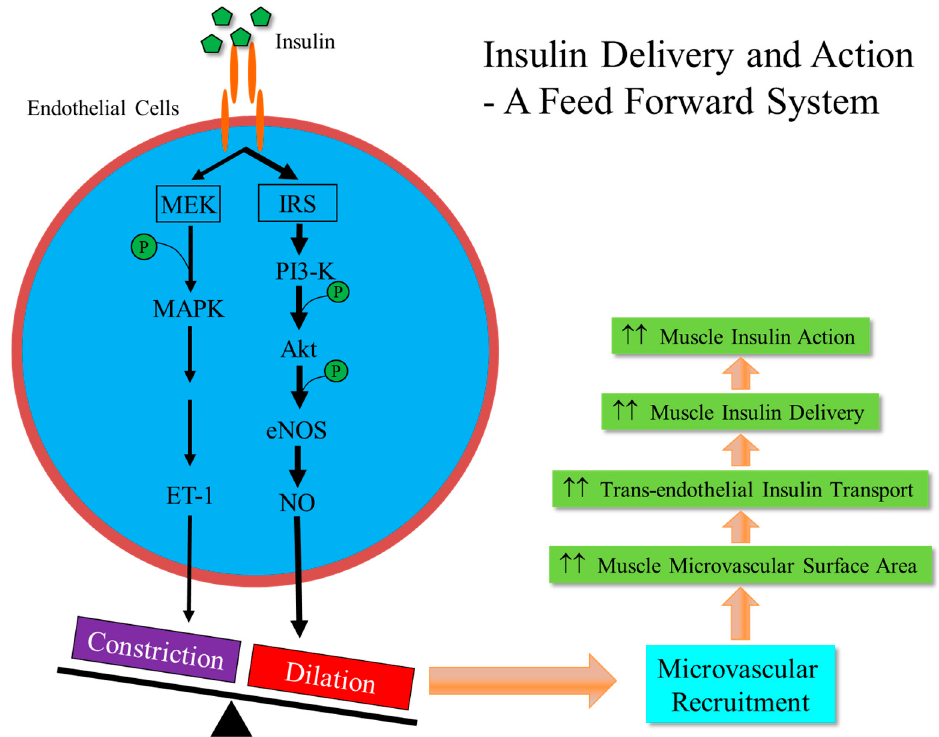
Figure 1. Insulin facilitates its own delivery to muscle through a feed forward system that is rate-limiting in insulin action. In the healthy state, insulin fine-tunes vascular tone and health via balancing its actions through the PI3-K/Akt/eNOS pathway and MAPK/ET-1 pathway. At high physiological levels, insulin’s effects on the PI3-K/Akt/eNOS pathway predominates, causing vasodilation and increased muscle capillary perfusion, a process called microvascular recruitment, and thus insulin delivery to the capillaries nurturing the myocytes. Insulin also enhances its own transport through the endothelial barrier from the plasma compartment to the muscle interstitium. (Abbreviations: IRS, insulin receptor substrates; PI3-K, phosphoinositide 3-kinase; Akt, protein kinase B; eNOS, endothelial NO synthase; MAPK, mitogen-activated protein kinase; ET-1, endothelin-1.)